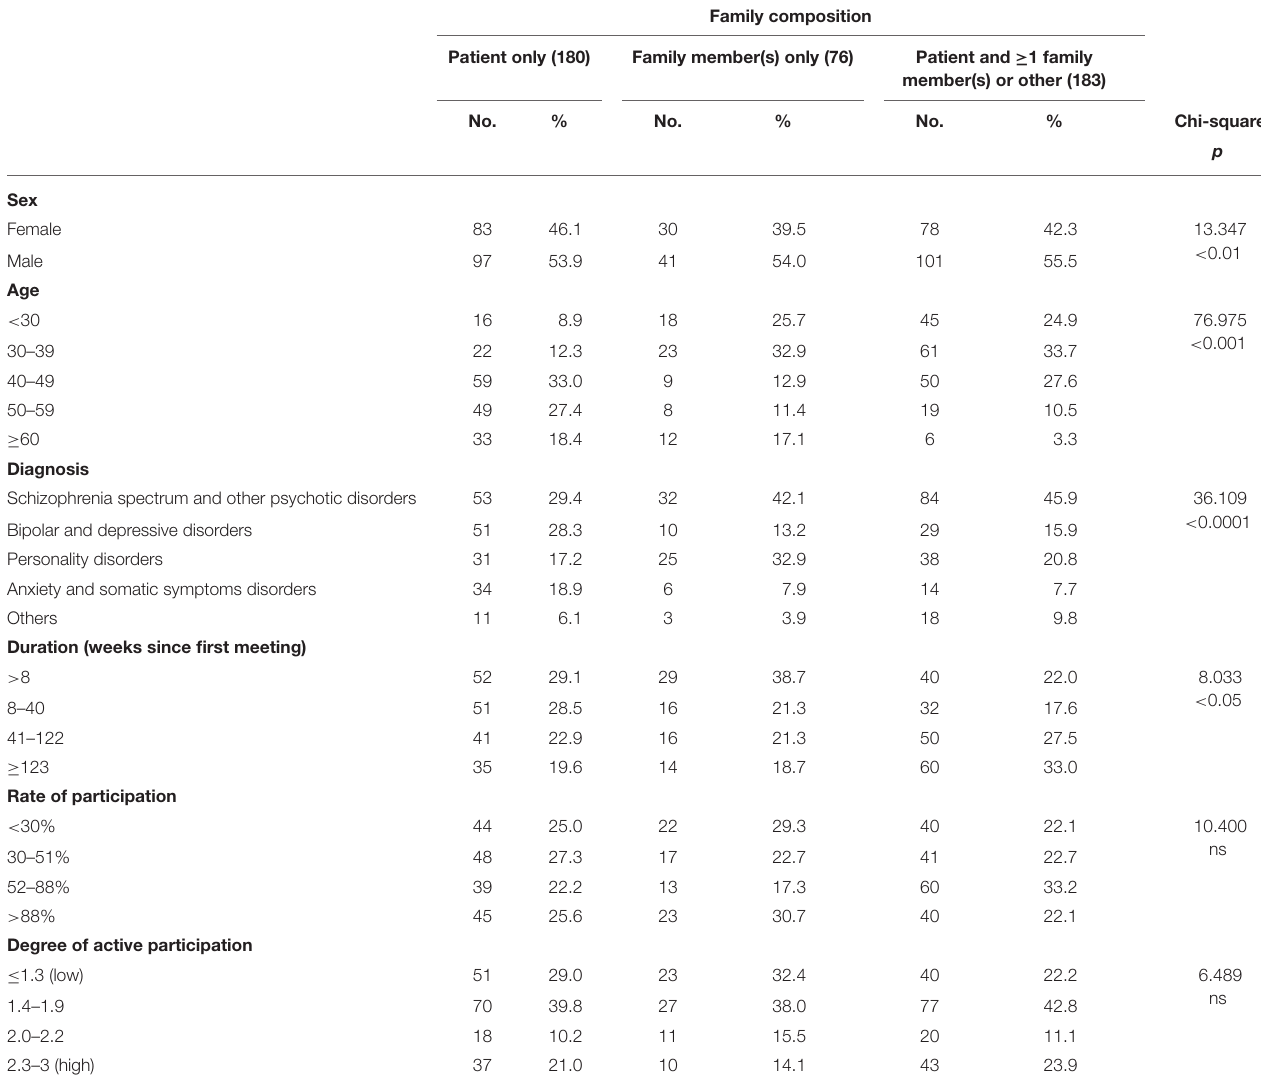
TABLE 1 | Composition of 439 families according to characteristics of the patient and participation of the family. Family composition Patient only (180) Family member(s) only